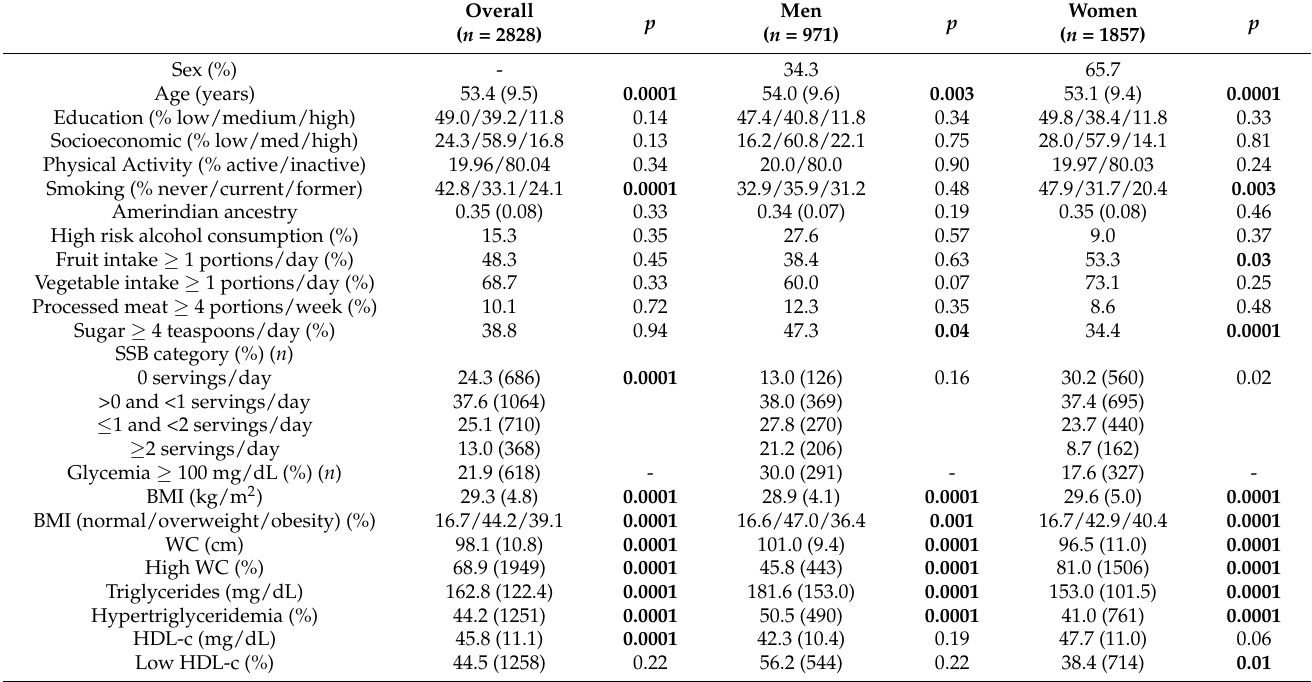
Table 1. General characteristics of